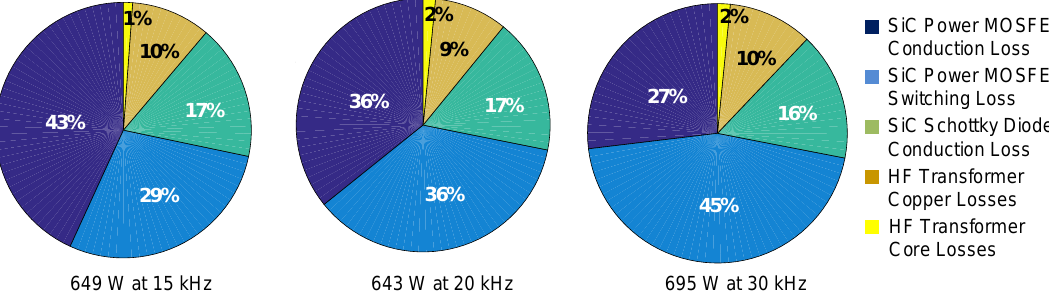
Figure 18. Power loss components of MPPT converter for different switching frequencies when P pv = 25.1 kW. Numerical values are rounded.